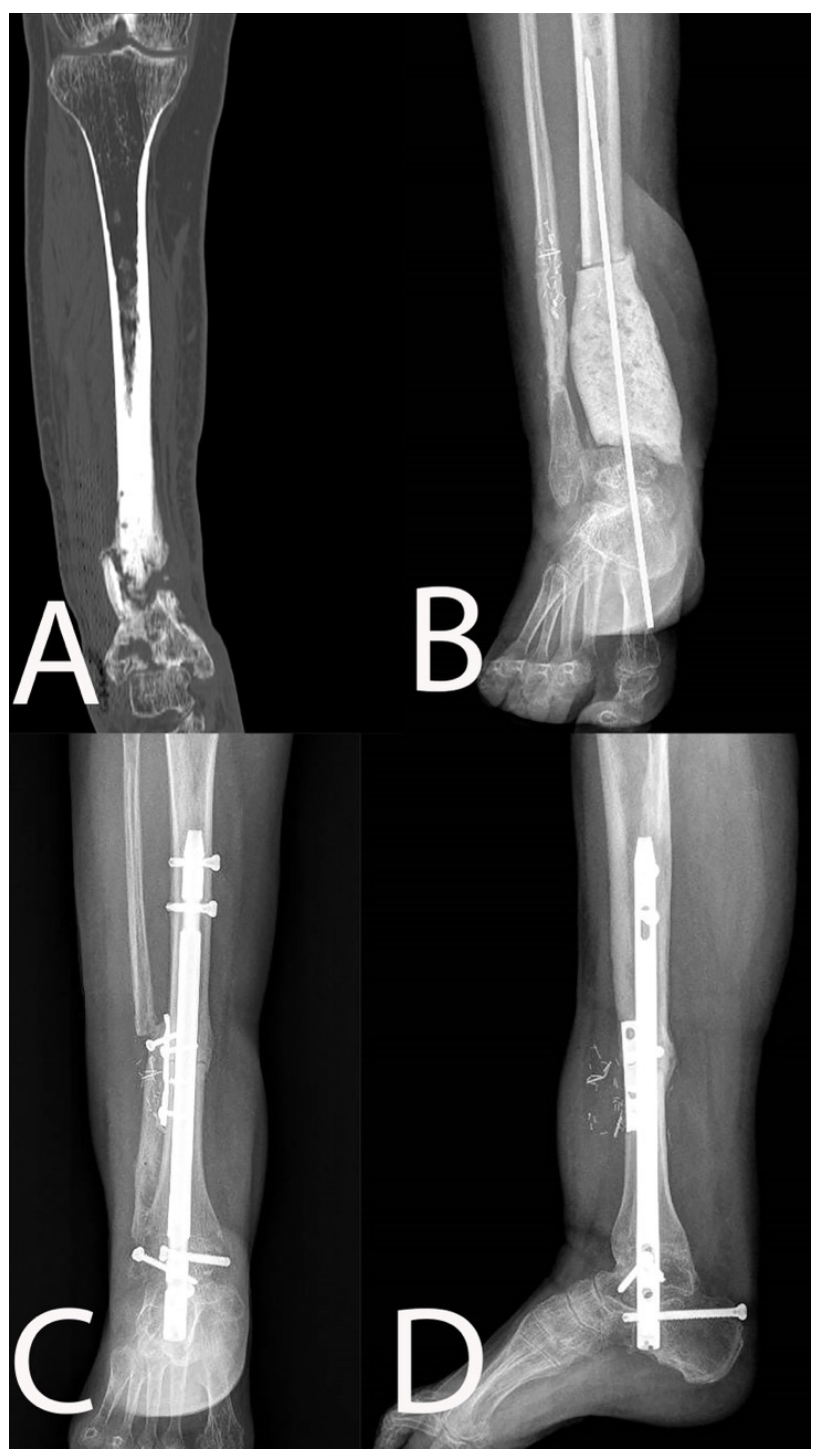
Figure 2. Chronic osteomyelitis of the distal tibia with non-healed pseudoarthrosis (( A ): pre-operative coronal view CT scan) treated with resection and antibiotic-loaded spacer (( B ): anteroposterior X-rays). Reconstruction was performed in ankle arthrodesis using a massive bone allograft and a nail (5 months follow-up X-rays, ( C ): anteroposterior view; ( D ): lateral view). The autologous homolateral fibula was transposed and fixed to the graft to improve reconstruction healing. Allografts were taken from the local bone bank and stored accord- ing to standard musculoskeletal banking rules. [28] One patient (#4) was reconstructed with a custom-made silver-coated prosthesis (Waldemar Link GmbH & Co. KG, Ham- burg, Germany) (Figure 3).